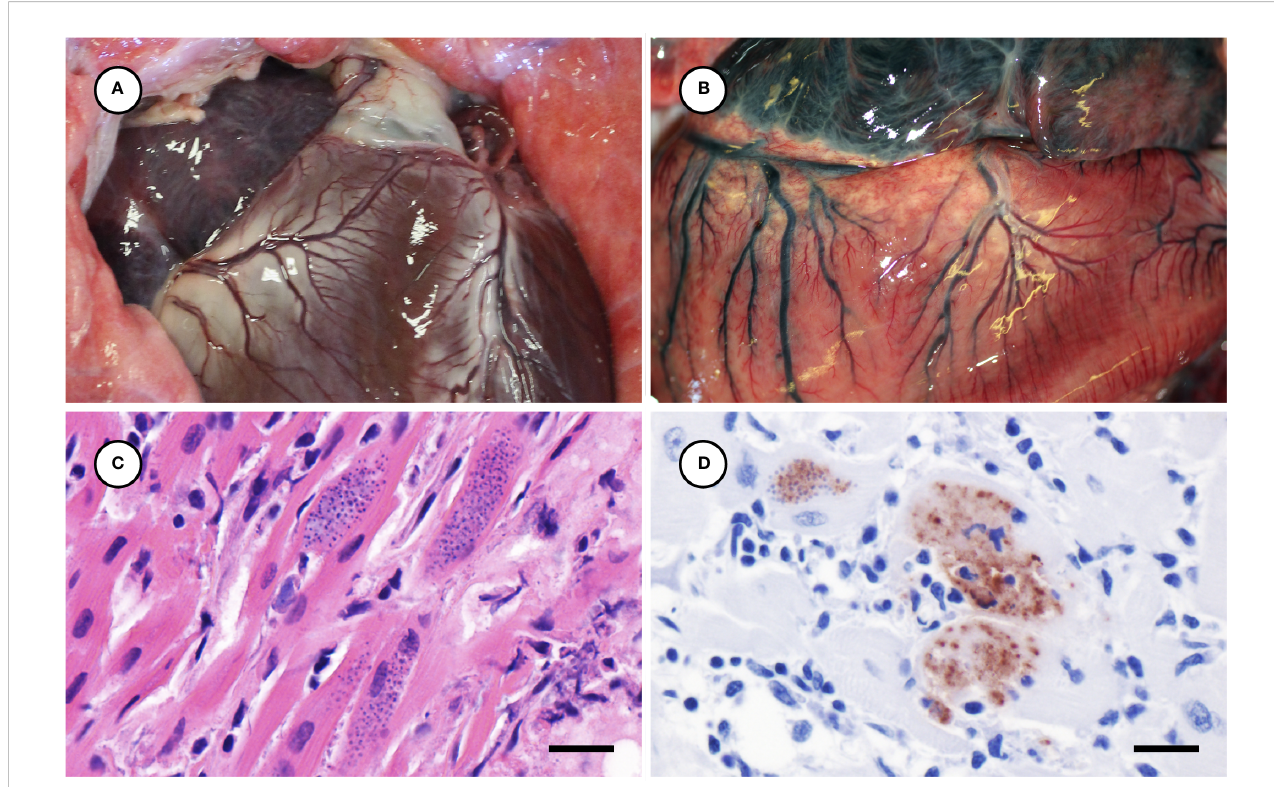
FIGURE 4 Normal heart from an unaffected sea otter (A) , compared with orange-discolored myocardium and pale yellow, multinodular-appearing epicardial adipose from a sea otter with protozoal myocarditis and epicardial steatitis (B) . Microscopic view of severely in fl amed myocardium (C) with numerous intralesional Toxoplasma gondii -like tissue cysts (H&E stain, bar = 10 µm). Immunohistochemical stain of in fl amed myocardium (D) demonstrating strong positive immunostaining of intralesional protozoa for T. gondii (Bar = 10